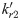
Role of PLK1 in stimulating mitotic entry and MPF kinase activation.(A) Approximated steady-state protein levels from studies by Watanabe et al. [38] using immunoblot analysis of PLK1T, WEE1T and WEE1P in HeLa cells following release from synchronization in the G1/S phase with mitosis observed between 9–10 hr. Arrows mark points of comparison between in vitro and in silico data. (P, phosphorylated protein; T, total protein) (B) Approximated steady-state protein levels of CDK1P (i.e. preMPF), PLK1P, CDC25CT and CDC25CP following release of HeLa cells from G1/S from studies by Gheghiani et al. [7]. (C) Simulation of PLK1 expression with oscillations in PLK1P, PLK1T, CDC25CT, CDC25CP, WEE1T, WEE1P, CCNBT, preMPF (CCNB1:CDK1P) and active MPF kinase (CCNB1:CDK1). Boxed area is magnified. (D) Approximated steady-state protein levels from experiments by Gheghiani et al. [7] described in (B) upon inhibition (+) of WEE1 kinase activity relative to control. (E) Percent of cells at mitotic entry as determined by Gheghiani et al. [7] using HEK293 cells expressing a wild-type CDC25C reporter or a phosphomimic CDC25C5E and following inhibition (+) of PLK1 compared to control. (F) Simulated inhibition of WEE1 (kr2′) and associated changes in factors as described in (C). (G) Simulated inhibition of PLK1 (kr6′) for wild-type CDC25C or phosphomimic CDC25C5E and associated changes as described in (C). Phosphomimic CDC25C5E is introduced by reducing PPase activity at kf3′ resulting in increased CDC25CP.